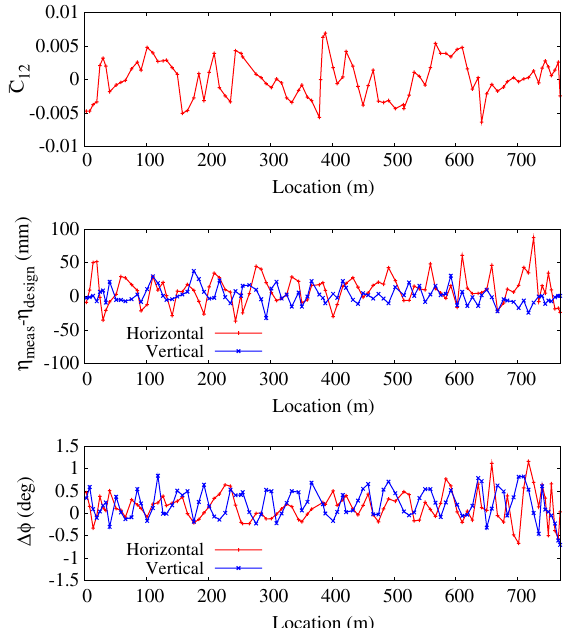
Model (with tail-cut) Model (without tail-cut) Data Monte Carlo (Natural Lattice) Data